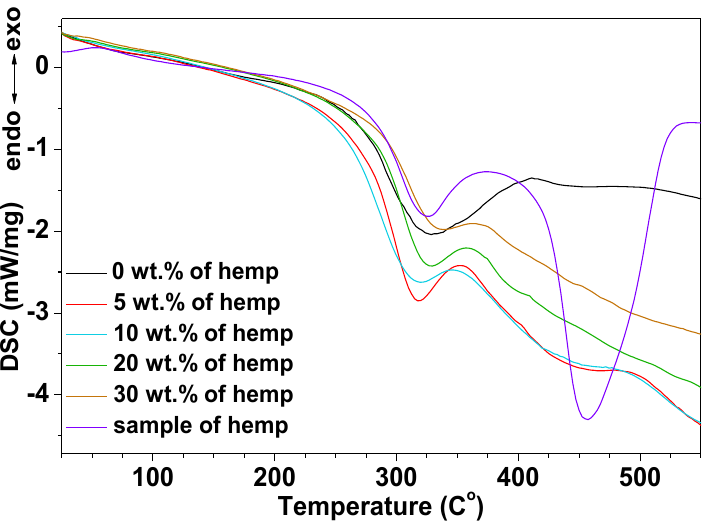
Figure 7. DSC curves of the obtained samples.